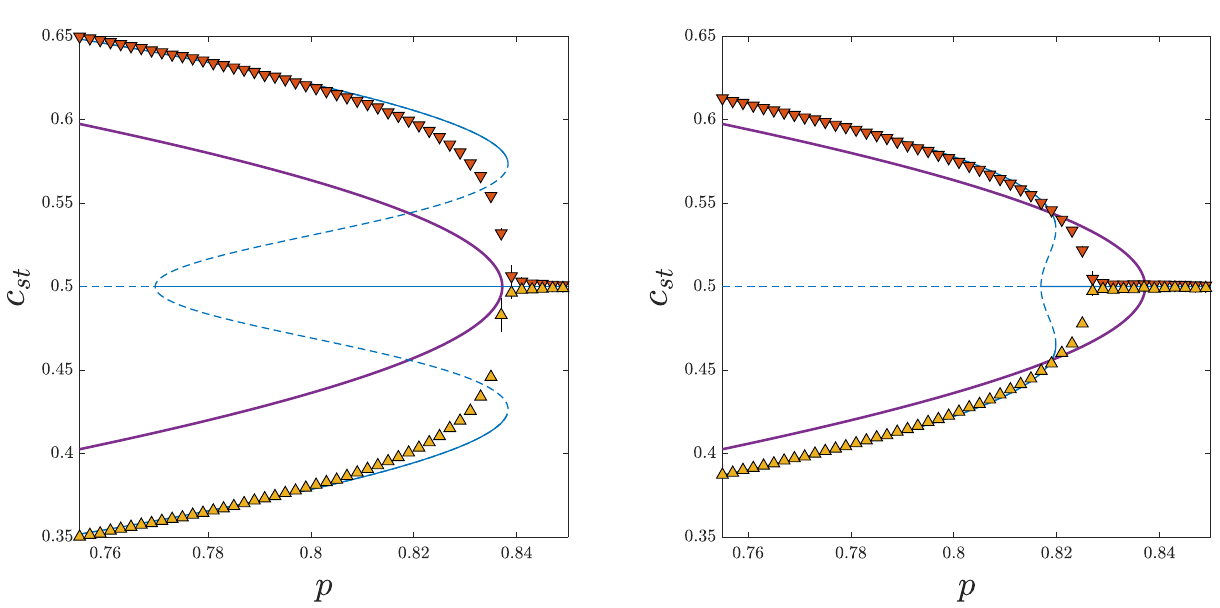
Figure 5. Dependence between the stationary concentration of up-spins c st and the probability of anticonformity p obtained within MFA (thick purple lines), PA (thin blue lines) and MC simulations (symbols) for q a = 13 , q c = 10 and k = 50 (left panel), k = 150 (right panel). Solid lines denote stable and dashed lines unstable fixed points. Results from the initial concentration of up-spins c 0 = 1 are presented in the upper parts of the panels (orange down-pointing triangles), whereas for c 0 = 0.5 in the bottom parts (yellow up-pointing triangles). Black vertical error bars represent the standard deviation of stationary concentration. They are visible only near the critical point and for all other values they are smaller than the size of the